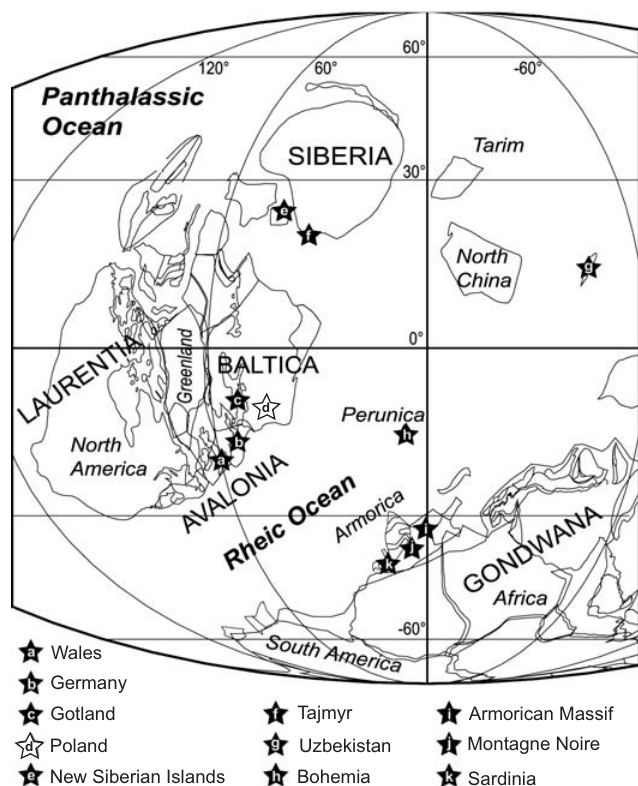
Fig. 10. Palaeogeographical distribution of Silurian myodocope bearing regions; map for Ludow (420 Ma, after Torsvik and Cocks 2013), but spe- cies span from late Wenlock to Pridoli. The position of the occurrence in Uzbekistan is poorly constrained